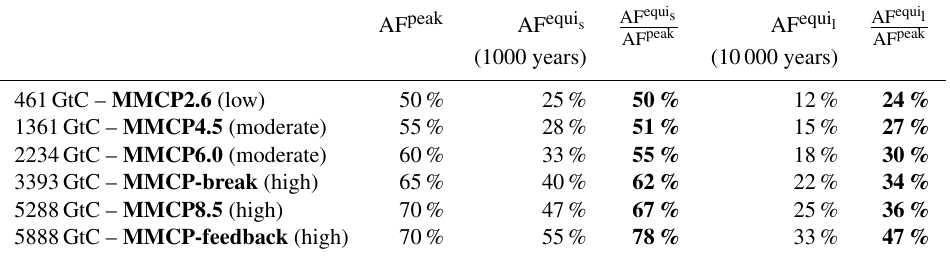
Table A2. Average equilibrium airborne fractions for total emissions of around 500 to 5000GtC according to the values given in Table A1. The equilibrium airborne fraction for 2000GtC is extrapolated from the average equilibrium airborne fraction for the 1000GtC and 5000GtC scenarios. The instantaneous airborne fraction is the airborne fraction reached after 1 year (AF peak ). Airborne fractions after 1000 and 10000 years are given. The columns highlighted in bold give the fractions of atmospheric CO 2 still present 1000 and 10000 years after the peak concentration. The numbers in the first column denote the cumulative emissions CO 2 emissions with respect to pre-industrial levels.